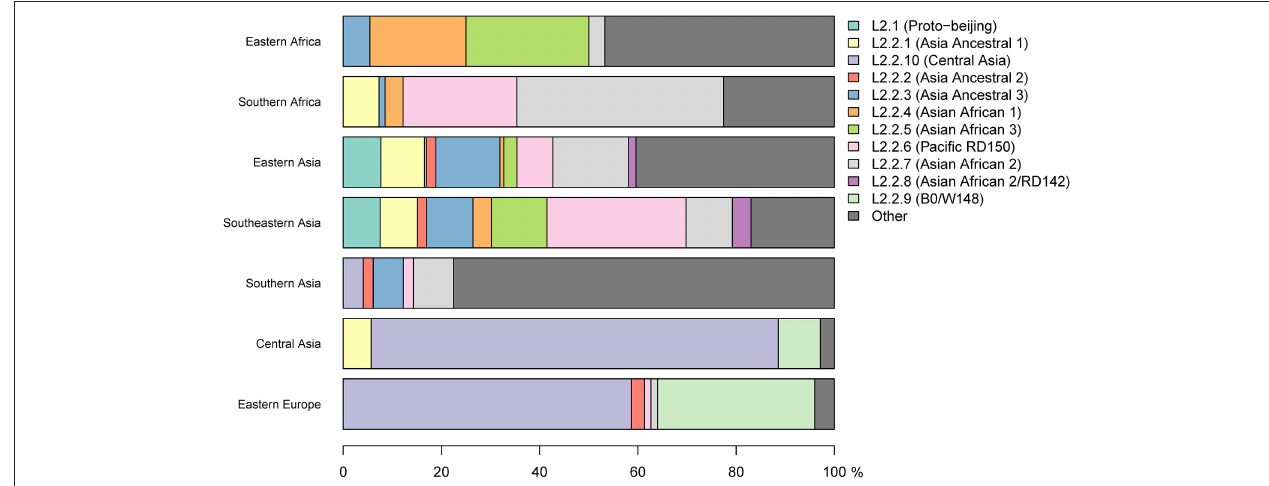
FIGURE 2 | Frequency in proportions of L2 sub-lineages across seven geographical regions.